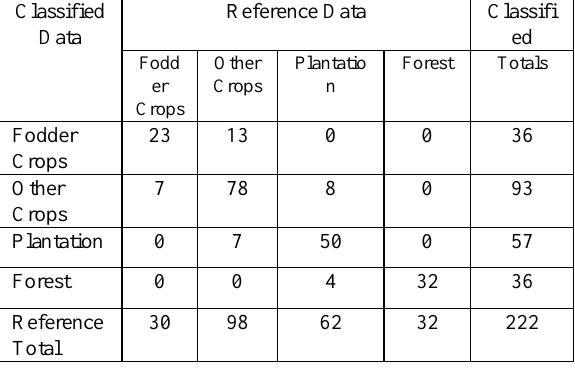
Table 2: Confusion Matrix for MLC